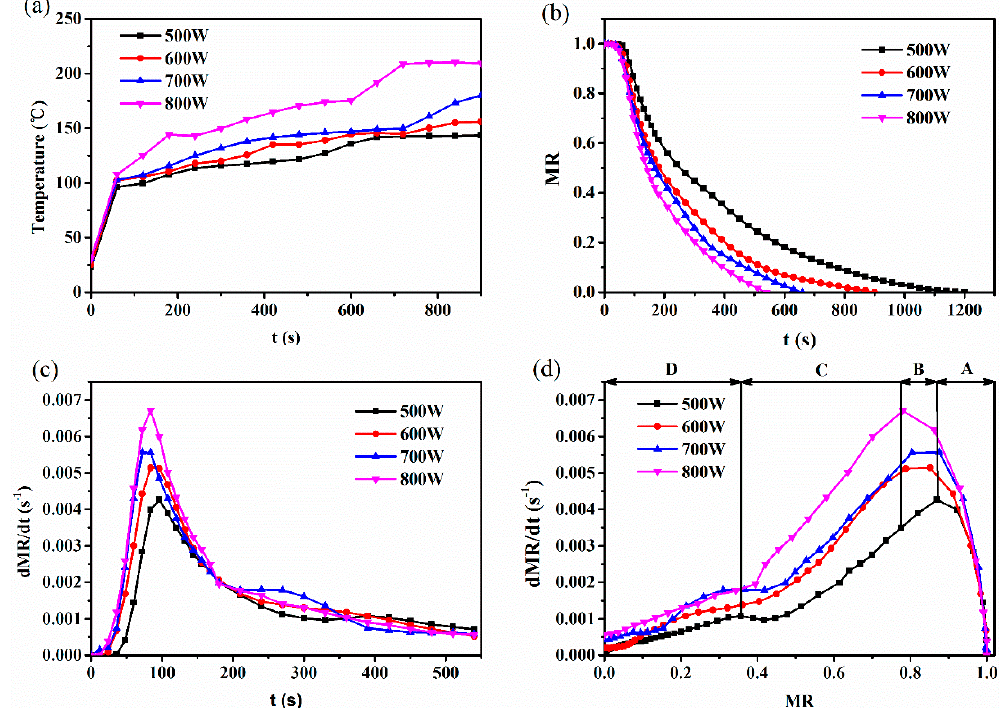
Figure 3. Drying curves of Zhaotong lignite at different microwave power levels. ( a ) Temperature vs. drying time; ( b ) moisture ratio vs. drying time; ( c ) drying rate vs. drying time; and ( d ) drying rate vs. moisture ratio.